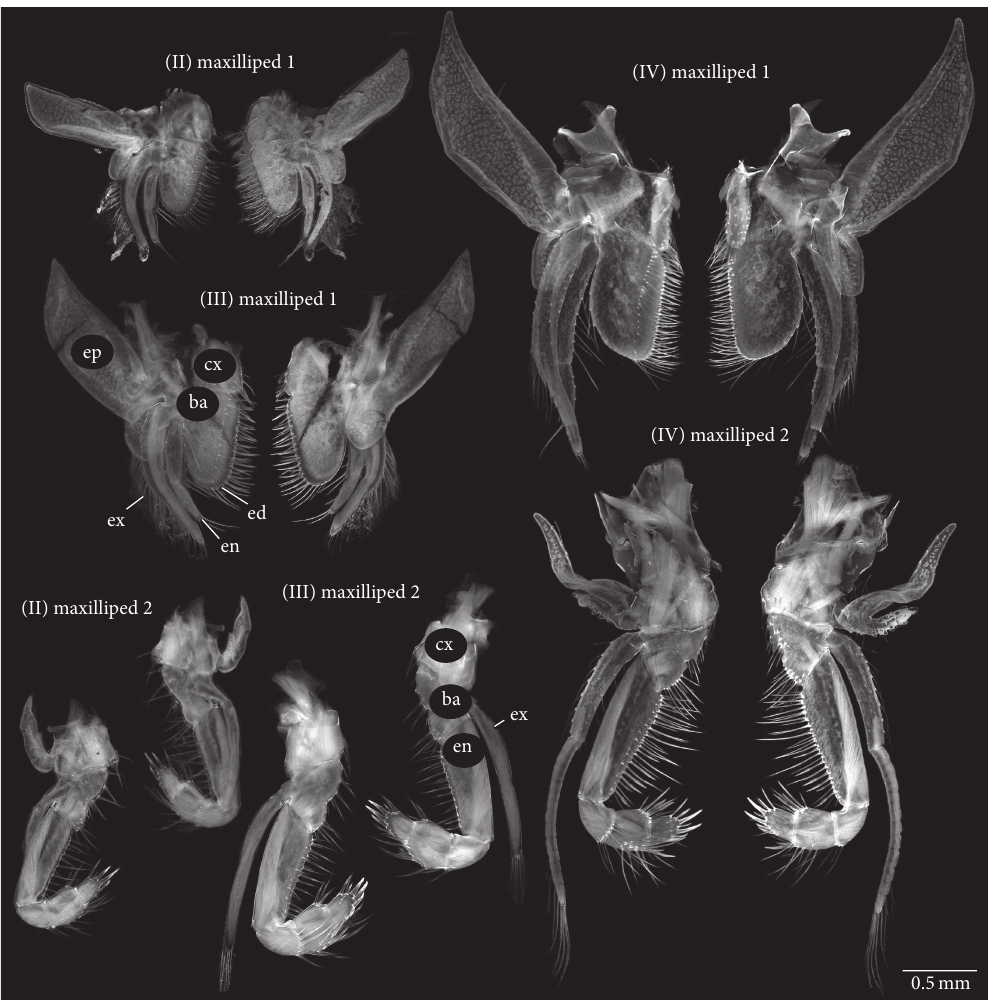
Figure 6: Maxilliped 1 and 2 of larval stages (II) to (IV) of Homarus gammarus . Right appendage in anterior (left) and posterior (right) view, besides (III) maxilliped 1 and (II) maxilliped 2, which are left ones flipped. Labeling only given in one instance due to the similarity of the structures throughout all stages. ba = basipod; cx = coxa; ed = endite; en = endopod; ep = epipod; ex =